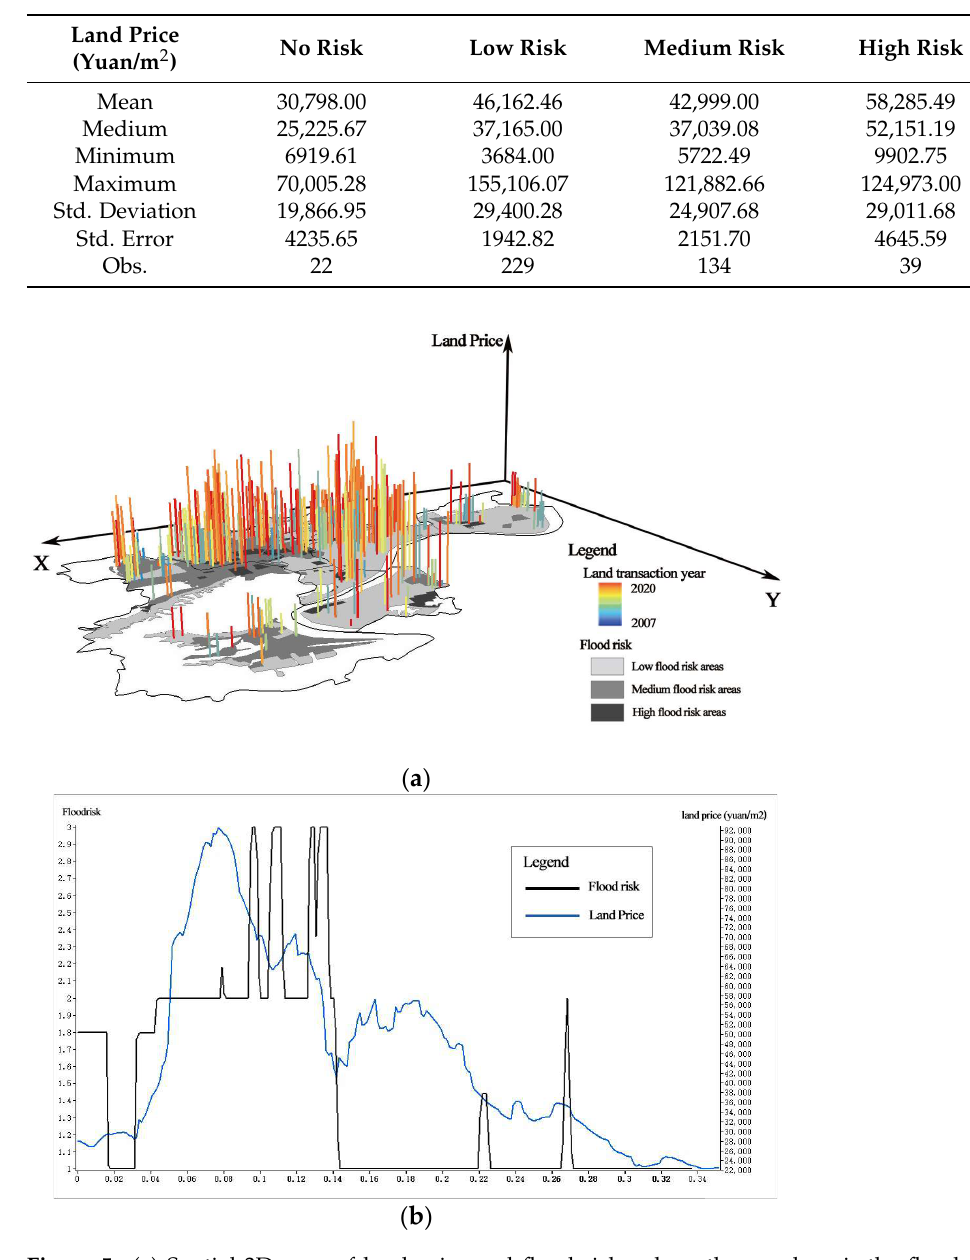
Figure 5. ( a ) Spatial 3D map of land price and flood risk, where the xy plane is the flood risk; ( b ) Sectional view of residential land price and flood risk, where the solid black line shows the flood risk curve from the west to east and the solid blue line shows the interpolated land price curve. Table 1. The descriptive statistics of residential land prices in different risk zones.